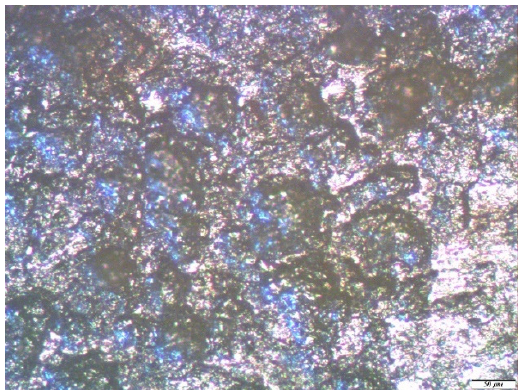
Figure 13. Micrograph of the surface area of an unmodified steel sample after the removal of the